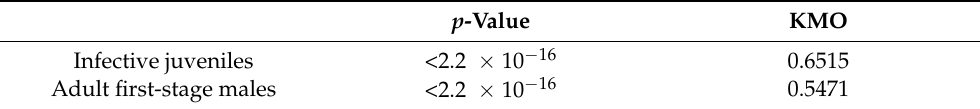
Table 8. p -Values in Bartlett’s test and Kaiser–Meyer–Olkin (KMO)